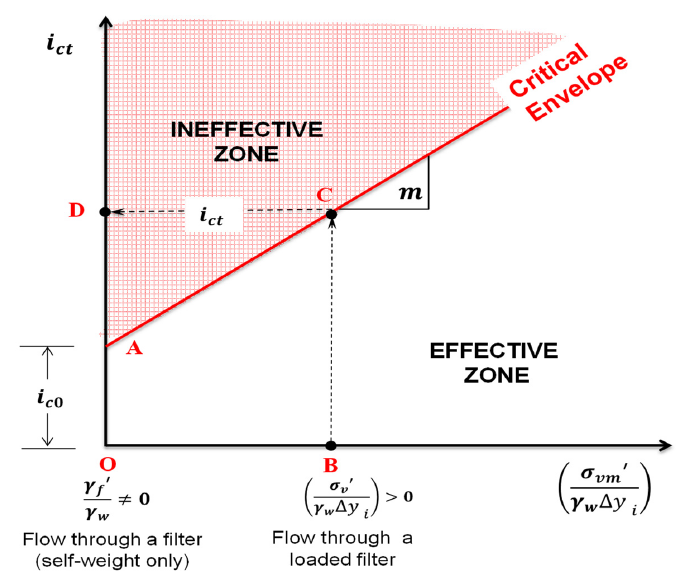
Figure 9. Proposed theoretical envelope to quantify the effectiveness of loaded granular